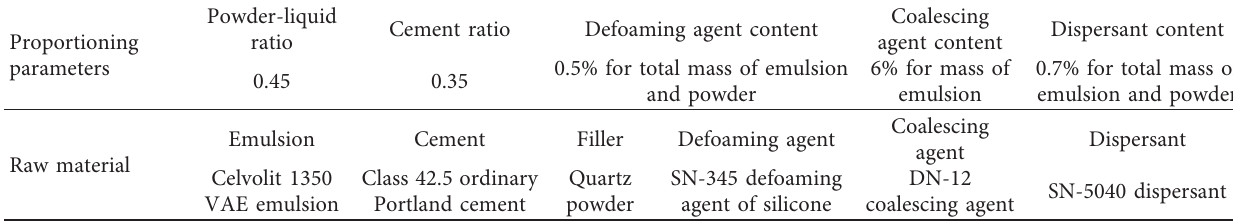
Table 1: Basic ratios of PCC.